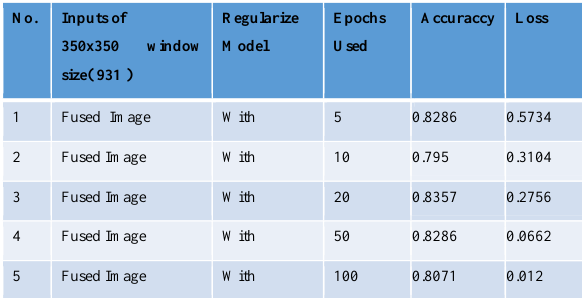
Table 6 . Fused Image Fused Image Window Size (256 X 256) Used for the Training of Model